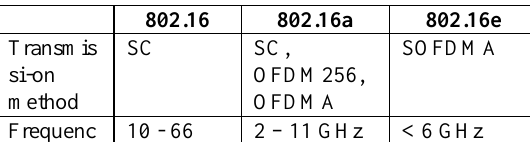
Table 3. Summary of Comparative